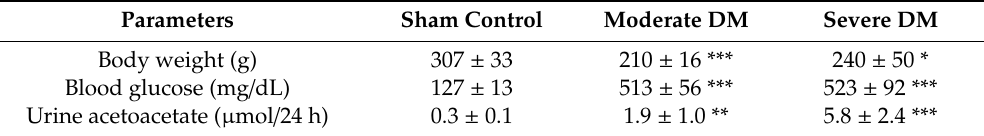
Table 3. General characteristics of rats used in this